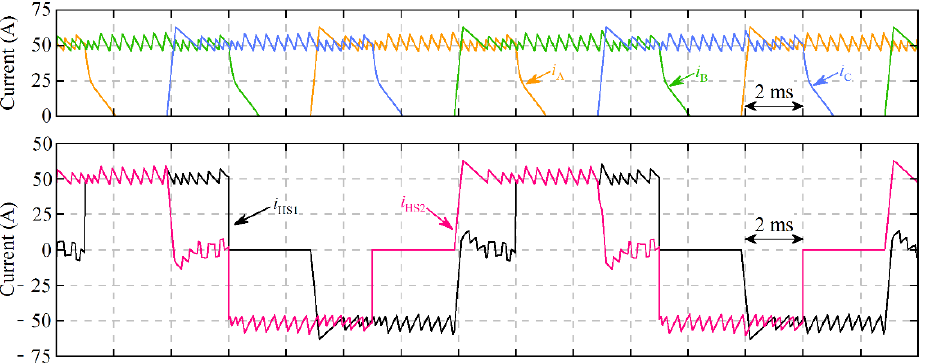
Figure 22. Experimental waveforms at 500 rpm ( i * = 50 A) with the proposed N p /2 + 1 sensors-based current detection scheme.